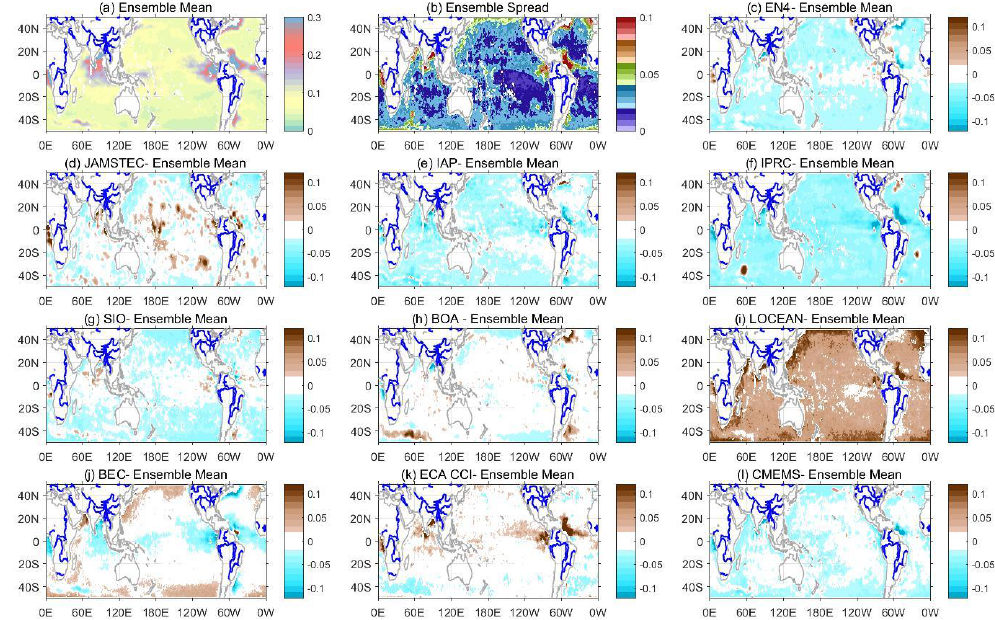
Figure 4. ( a ) The STD of the ensemble mean of SSS on the sub-annual time scale. ( b ) The spread of the STD of the sub-annual SSS time series based on ten products. ( c – j ) The difference between the STDs of the sub-annual SSS signal from individual products and the ensemble mean. The blue lines in ( a – l ) denote the major rivers worldwide.